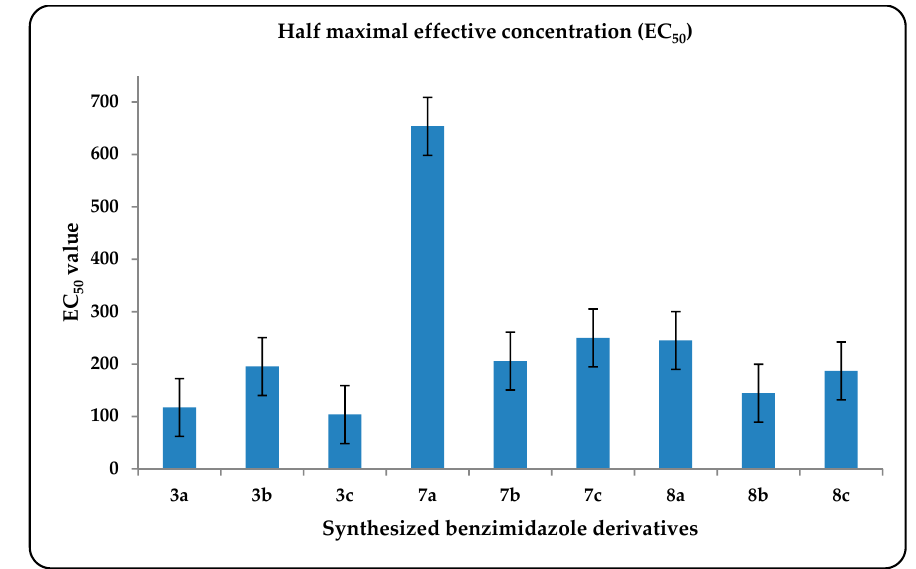
Figure 3. The average results of EC 50 for the tested synthesized benzimidazoles based on three independent experiments.